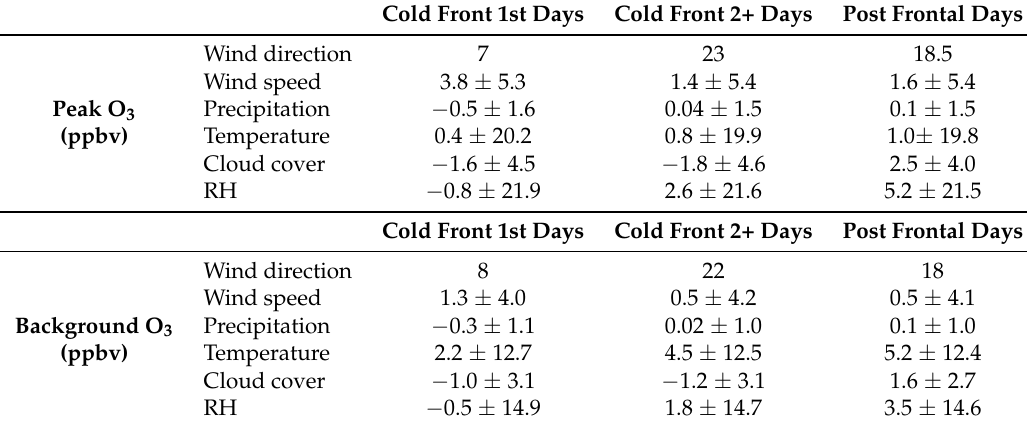
Table 2. O 3 difference caused by meteorology compared to no front